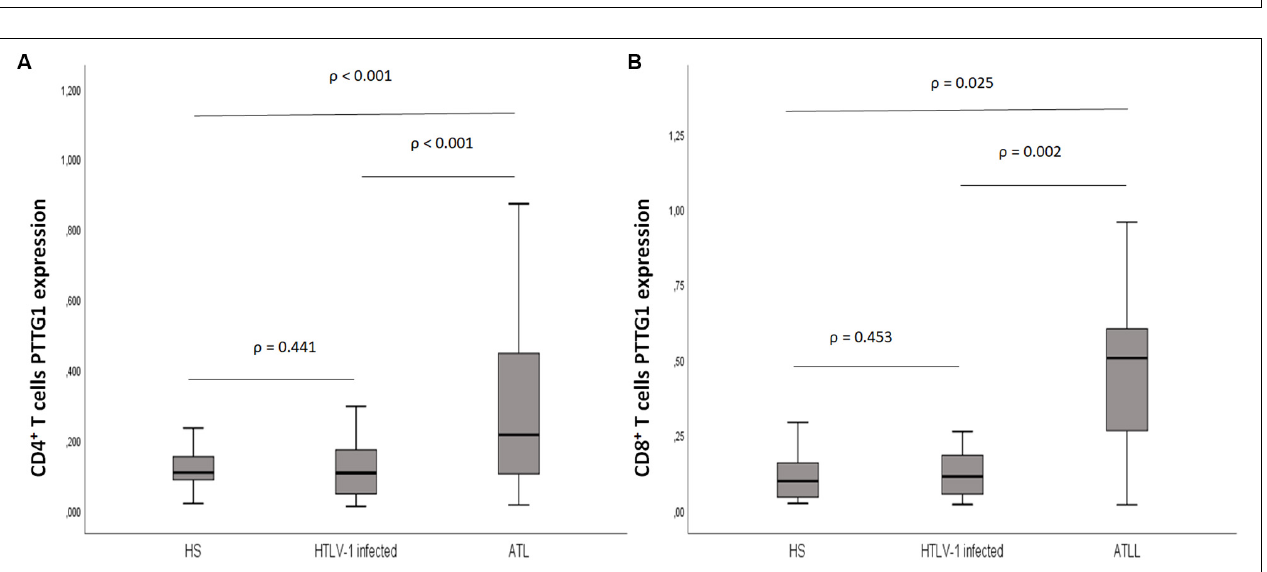
FIGURE 4 | PTTG1 gene expression of T lymphocyte CD4 + and CD8 + T cells. (A) CD4 + T cells; (B) CD8 + T cells. Distribution pattern of the median intensity of gene expression between health subjects, HTLV-1 asymptomatic carriers and ATL. The data represents the median, the minimum and maximum value of the PTTG1 expression; between the minimum and maximum values, is the interquartile range. HS, Health subjects; HTLV-1 infected, HTLV-1 asymptomatic carriers; ATL, Adult T-cell leukemia/lymphoma.